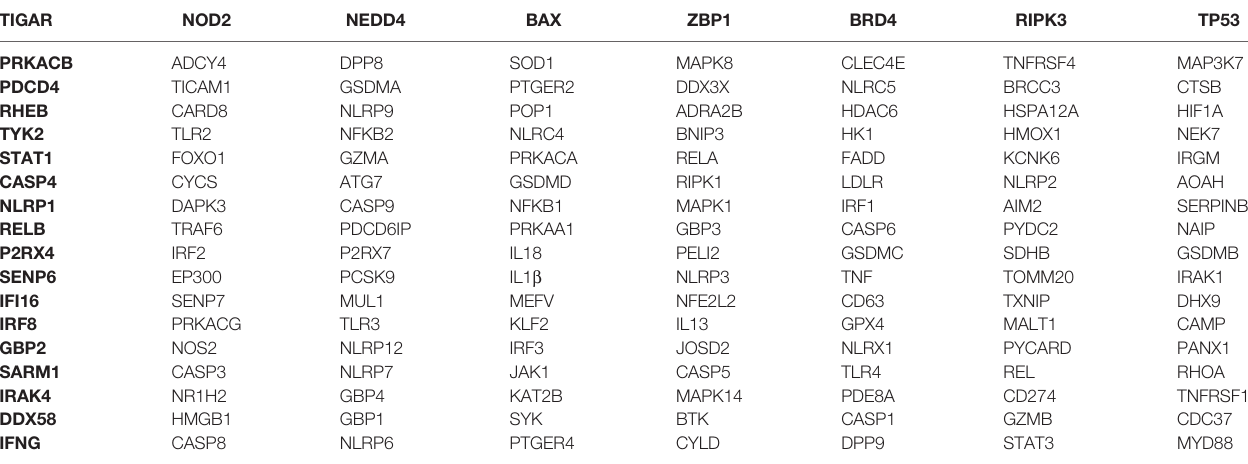
TABLE 1 | One hundred and forty-four pyroptosis-related genes collected from published literature.